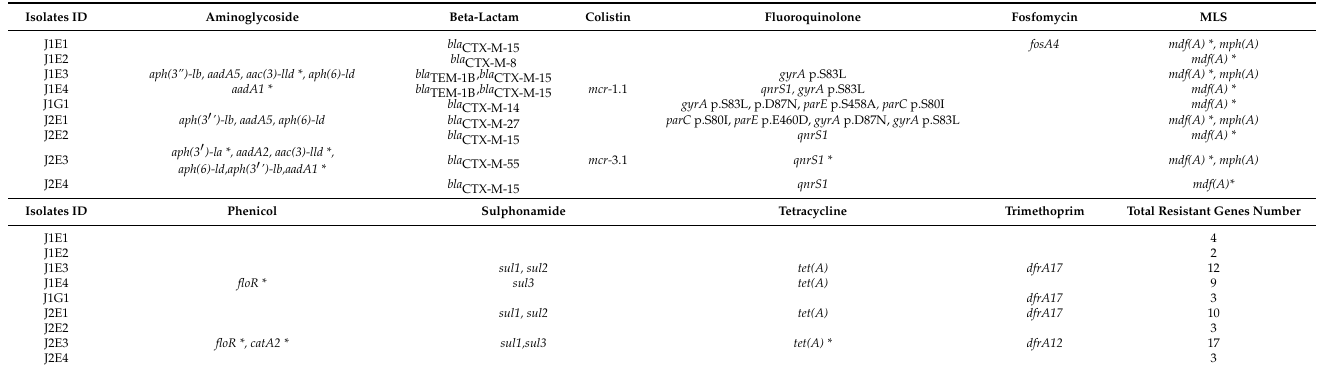
Table 2. Acquired resistance genes and resistance-related mutations detected in isolates by ResFinder.